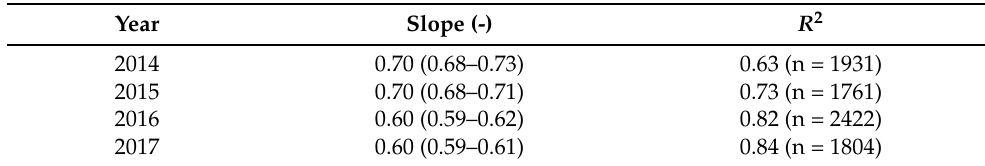
Table 1. Energy balance closure slopes after the linear regression. All regressions were significant ( p < 0.05). The intercept was not forced through